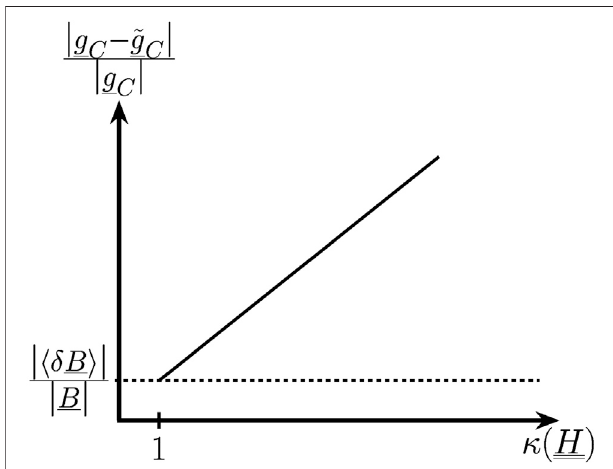
FIGURE 1 | Sketch of the upper bound for the relative estimation error resulting from measurement errors with respect to the condition number κ (cid:1) H (cid:3) of the shape